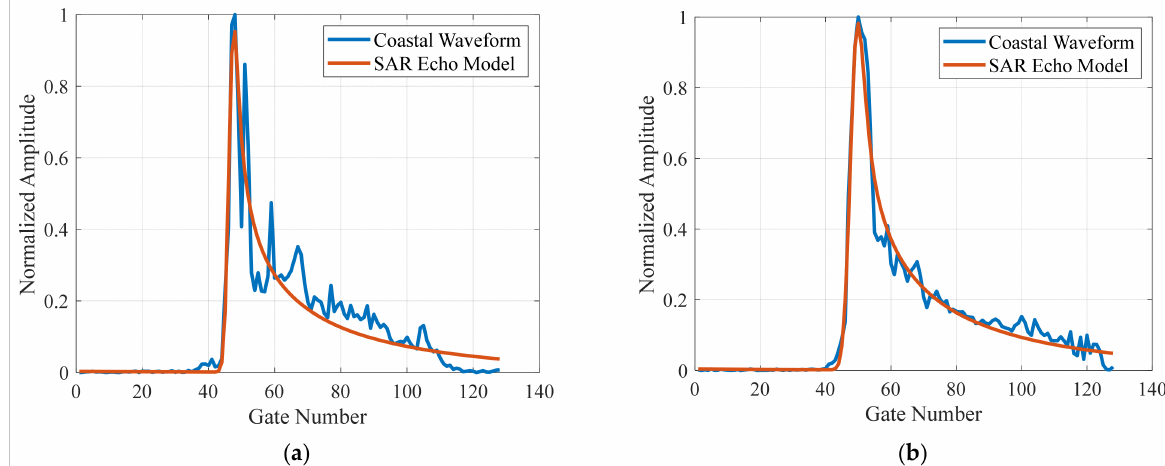
Figure 11. Two typical retracking results of the reconstructed coastal waveforms ( a , b ). The blue curves represent the reconstructed coastal waveforms, and the red curves represent the final iteration results of the echo model.